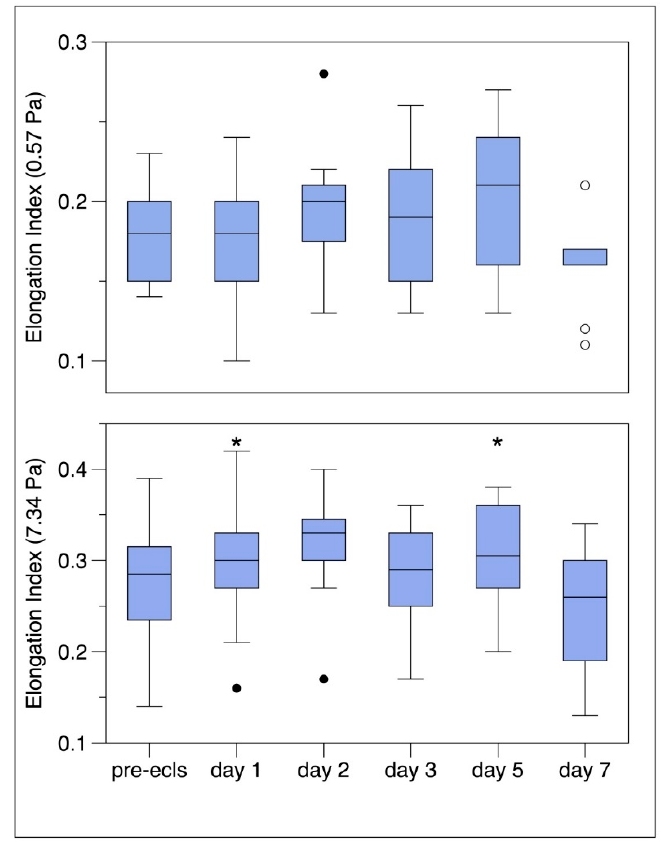
Figure 4. Elongation index at low shear stress (0.57Pa) and elongation index at high shear stress (7.34 Pa). Boxes represent the interquartile range (25%–75%), dots represent the outliers. * p = 0.05 indicating significant difference with pre ECLS value. ECLS = extracorporeal life support.